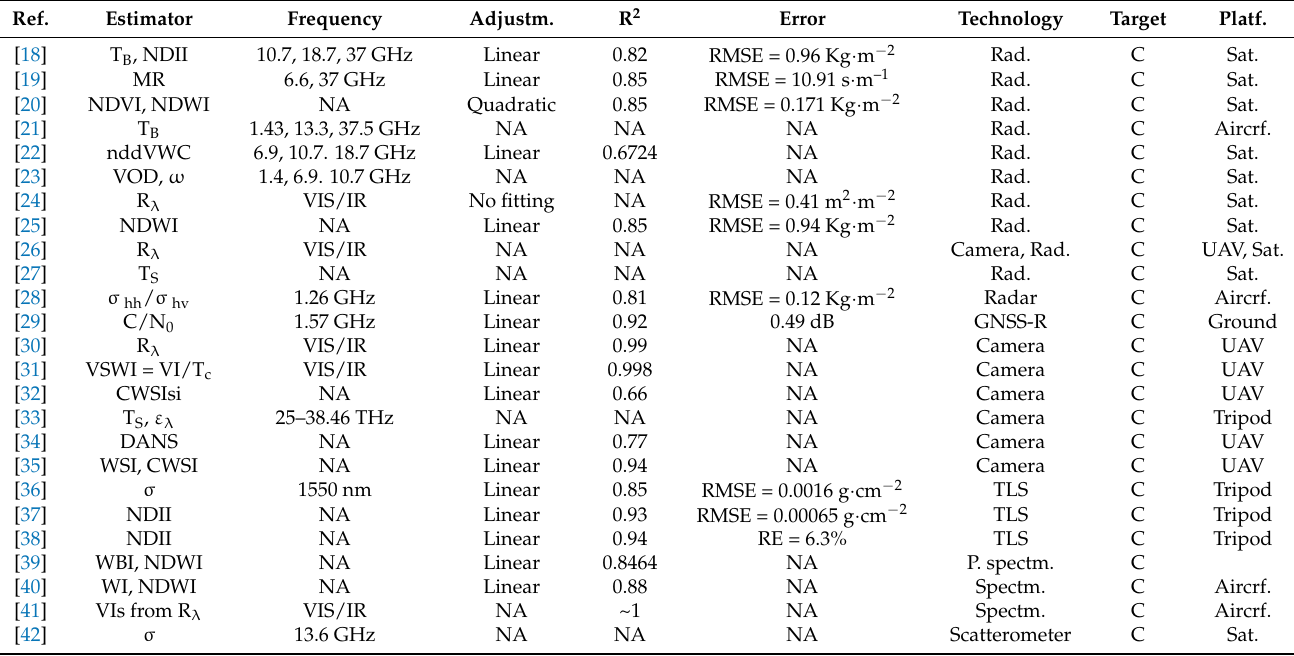
Table 3. Summary of the estimators used in canopy techniques together with the operating frequency, type of adjustment, R 2 , estimation error, technology, target and sensor platform.